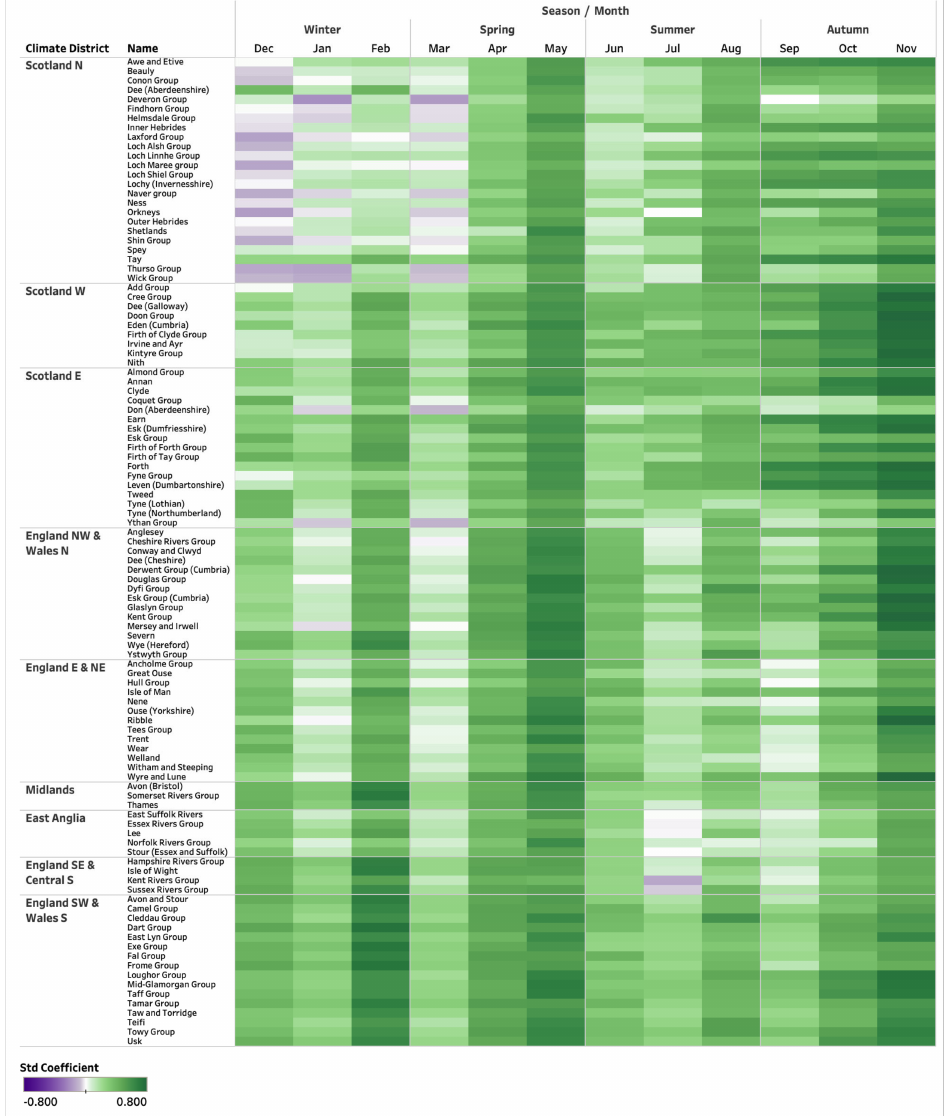
Figure 6. Standardised coefficient values for the EA index from the multivariate regression